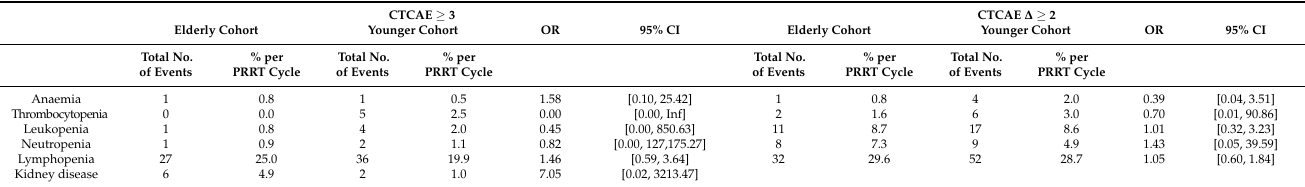
Table 4. Estimated odds ratios of older vs. younger patients for subacute adverse events *, obtained by complete-case analyses, with confidence intervals for the non-inferiority of older vs. younger patients (with relative non-inferiority margin